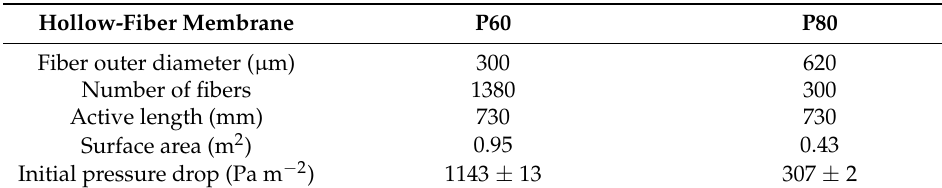
Table 1. Basic parameters of the hollow ‐ fiber membranes.